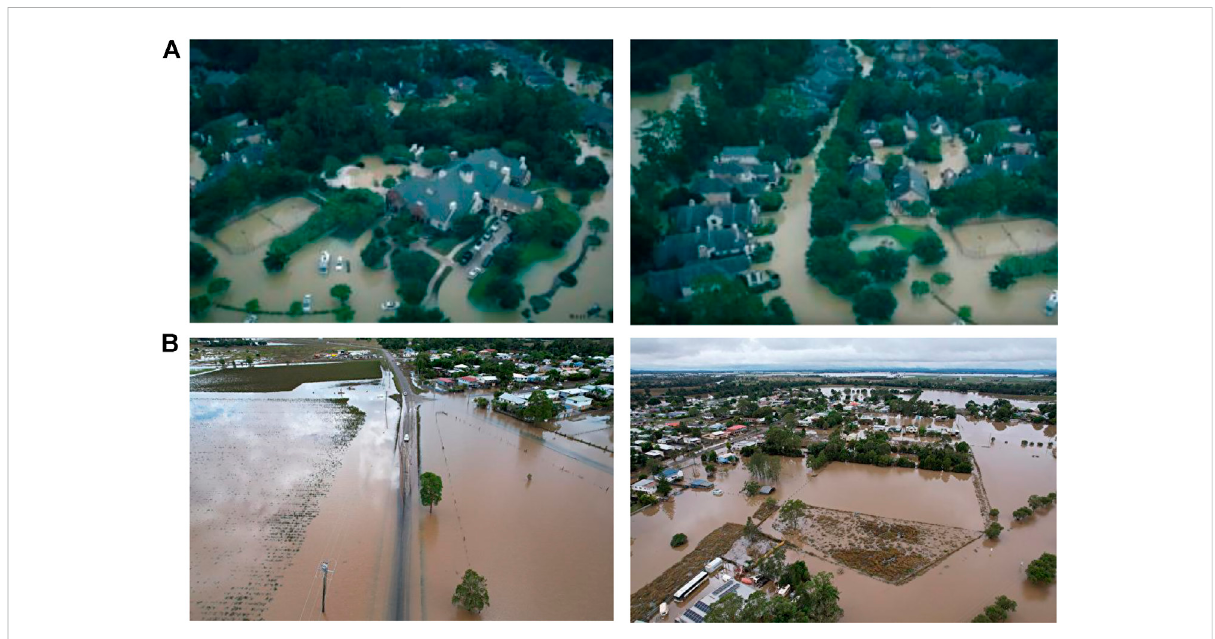
FIGURE 1 Oblique aerial photographs taken over (A) fl ooded urban areas in the Barrington Kingwood area, Houston (Chini et al., 2019); (B) fl ooded roads and houses in Coraki, Australia, 7 March 2022 (Photo by Dan Peled/Getty